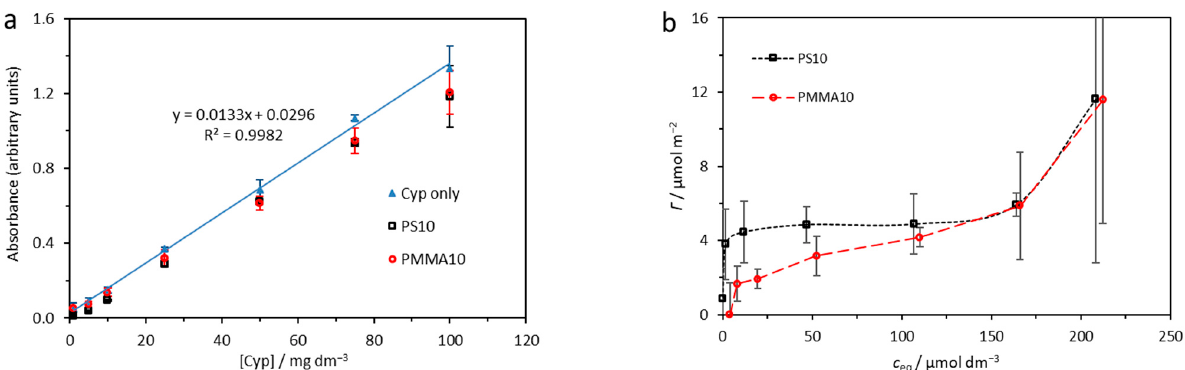
Figure 1. ( a ) Absorbance (mean ± SD) at a wavelength of 279 nm as a function of cypermethrin ( γ 0 (Cyp) = [Cyp]) added to 10 μ m polystyrene (PS10) and polymethylmethacrylate (PMMA10) microparticle suspensions. ( b ) Surface concentration (mean ± SD) of cypermethrin ( Γ ) on microplastics with respect to cypermethrin concentration (c eq ) in solution.